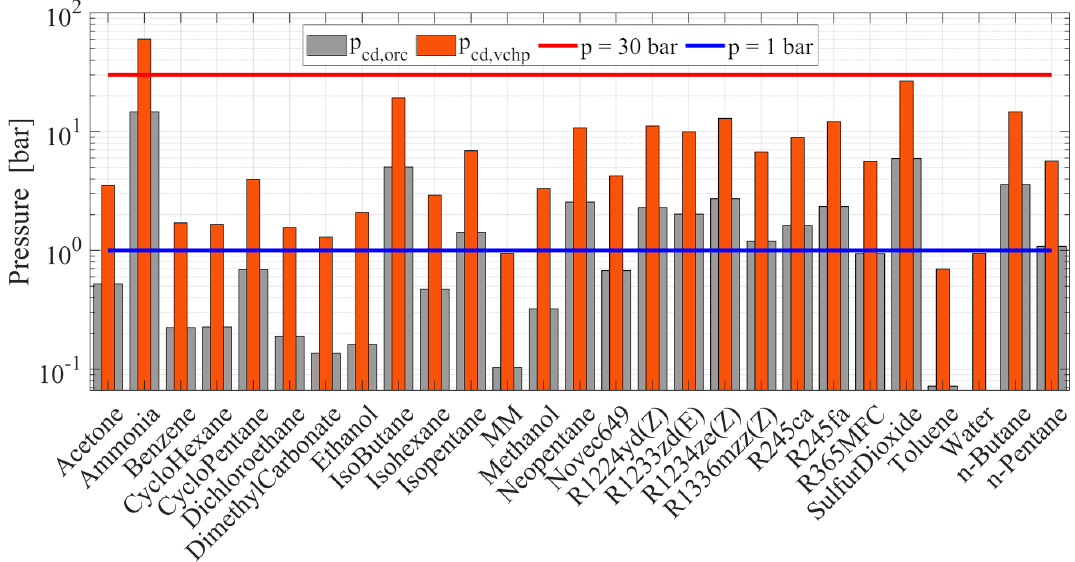
Figure 5. TI-PTES operating pressures in the VCHP and ORC condensers, p cd,vchp and p cd,orc , respectively, for several operating fluids. The results are related to the configuration in Figure 6 investigated in [22]. Minimum and maximum recommended pressure levels are also reported.